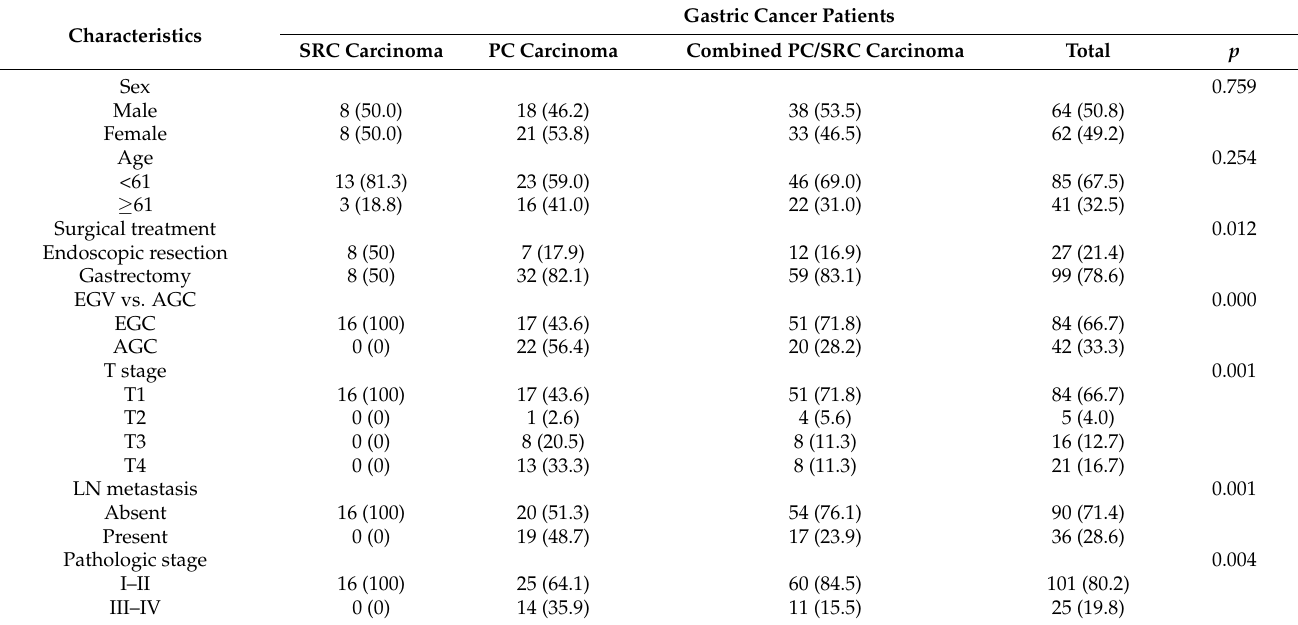
Table 2. Clinicopathologic characteristics of SRC, PC, and combined PC/SRC gastric carcinomas ( n =